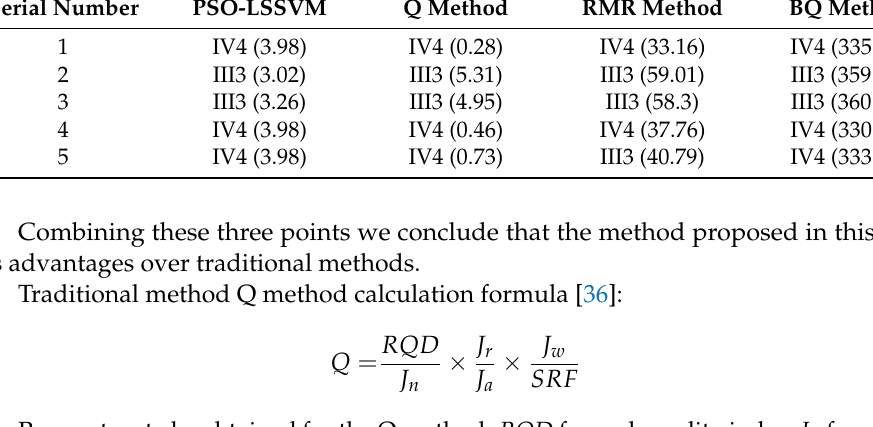
Table 3. Prediction results of PSO-LSSVM compared with traditional methods. Serial